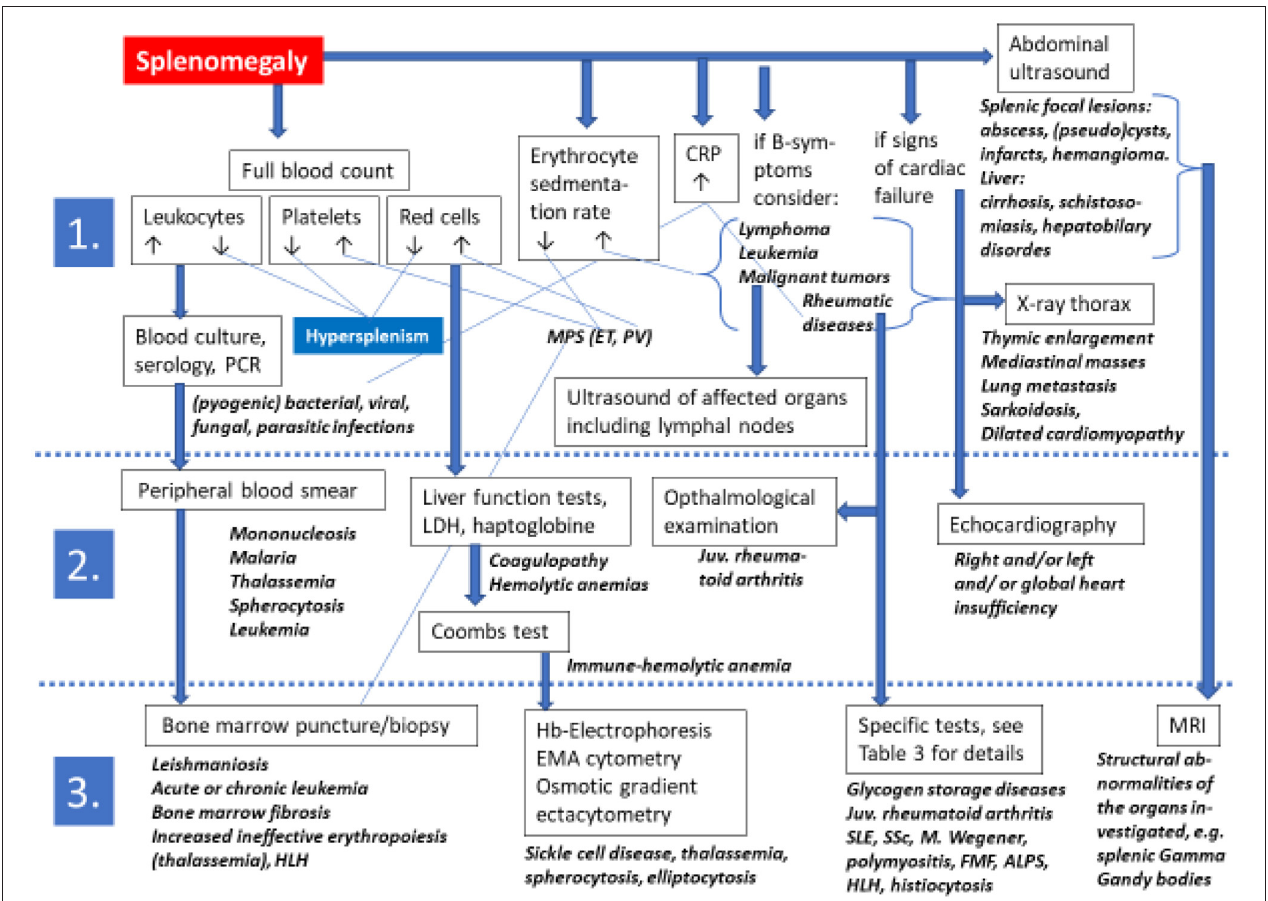
FIGURE 3 | Algorithms for a non-evidence based diagnostic approach toward a pediatric or adolescent patient presenting with splenomegaly on physical examination. Diagnostic steps are grouped into 1st line, 2nd line, and 3rd line approaches. The extensive list of differential diagnoses excludes more detailed information in this flow chart for which the reader is kindly referred to the text and to Table 3 of this review. ALPS, autoimmune lymphoproliferative syndrome; CRP C, reactive protein; EMA, eosin-5’-maleimide; FMF, familial Mediterranean fever; Hb, hemoglobin; HLH, hemophagocytic lymphohistiocytosis; juv., juvenile; LDH, lactate dehydrogenase; MRI, magnetic resonance imaging; PCR, polymerase chain reaction; SLE, systemic lupus erythematosus; SSc, systemic sclerosis.